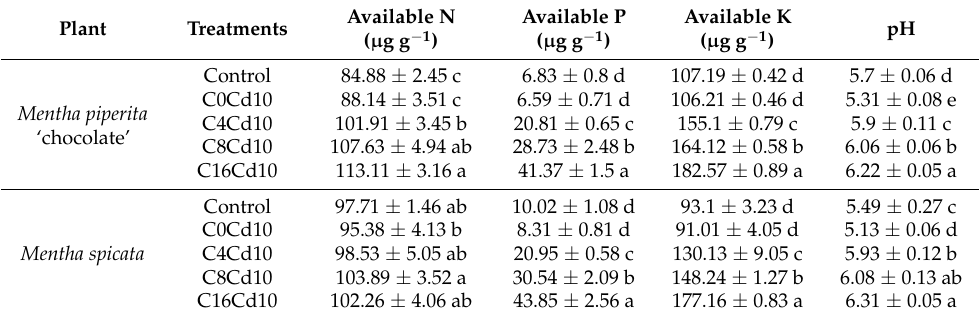
Table 2. Effect of biochar on soil characteristics under Cd stress.